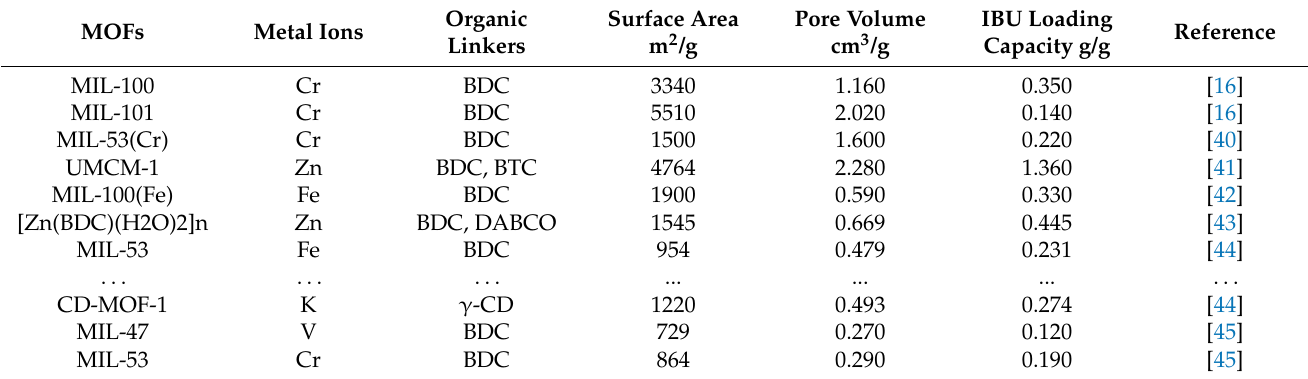
Table 1. Sample of partial data and the predicted target (IBU loading capacity)